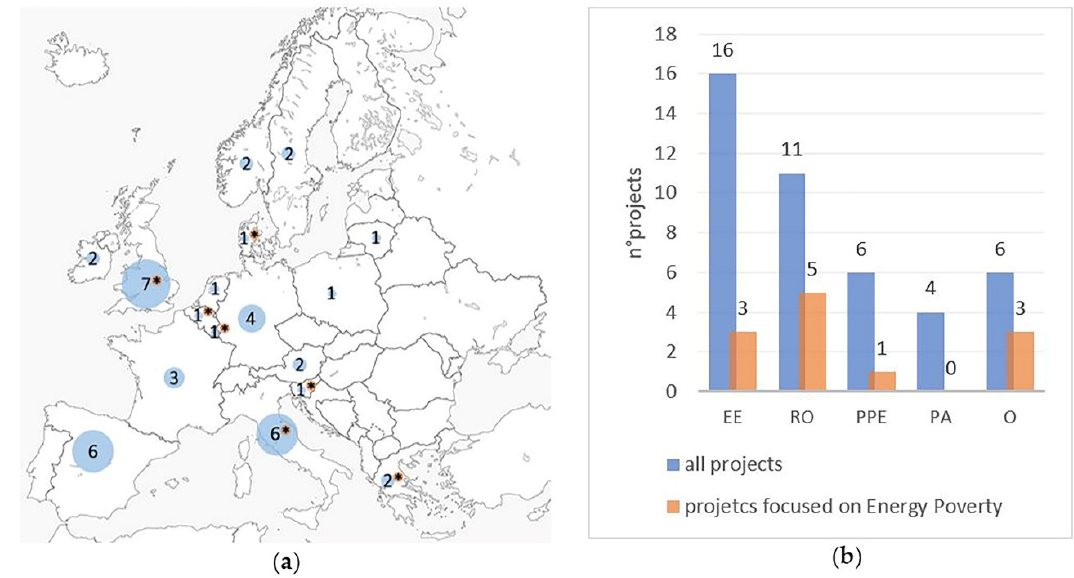
Figure 5. ( a ) Project leader distribution (* pointed projects specifically focused on energy poverty); ( b )